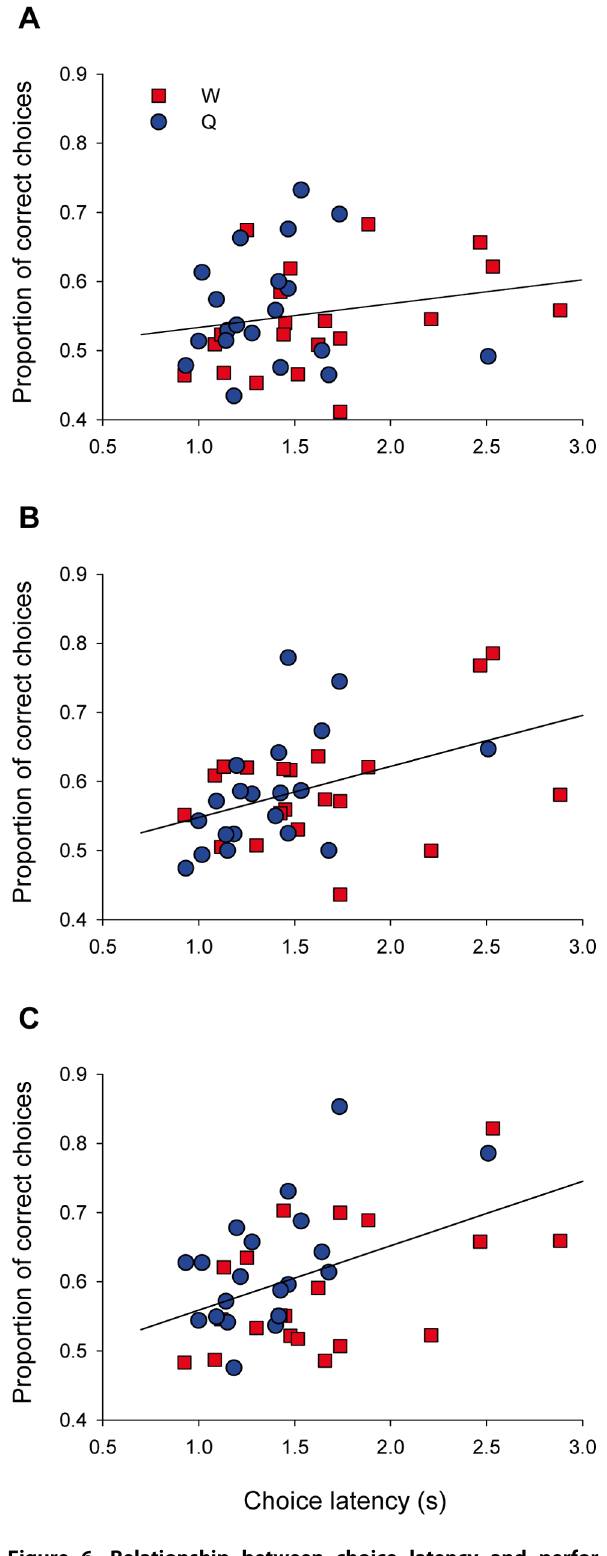
Figure 6. Relationship between choice latency and perfor- mance during phase 1. Each dot represents the choice latency and performance for an individual bee. Latencies are calculated as the averages of those measured in trials 14 and 29. Performance is the proportion of correct choices over a block, for (A) block 1 (trials 1–5), (B) block 2 (trials 6–10) and (C) block 3 (trials 11–14). Symbol type